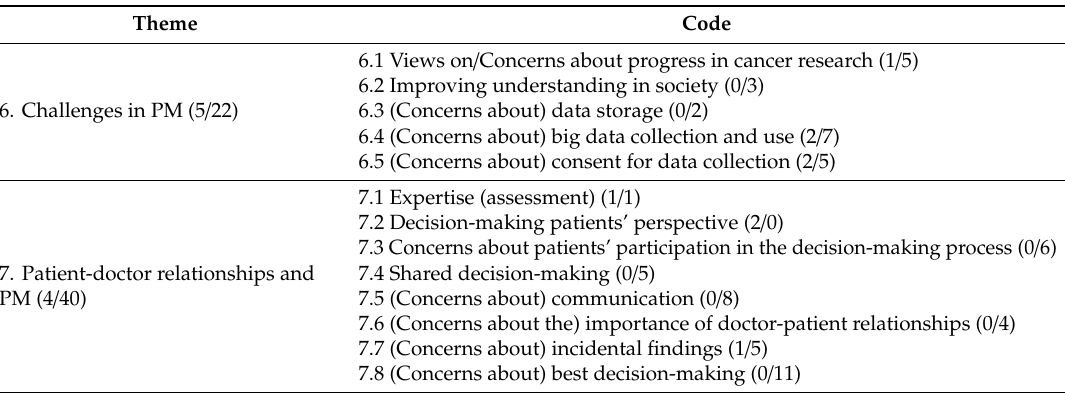
Table 1—i.e., {1.1, . . . , 7.8}—and were colored subject to the theme they belonged to. Whenever